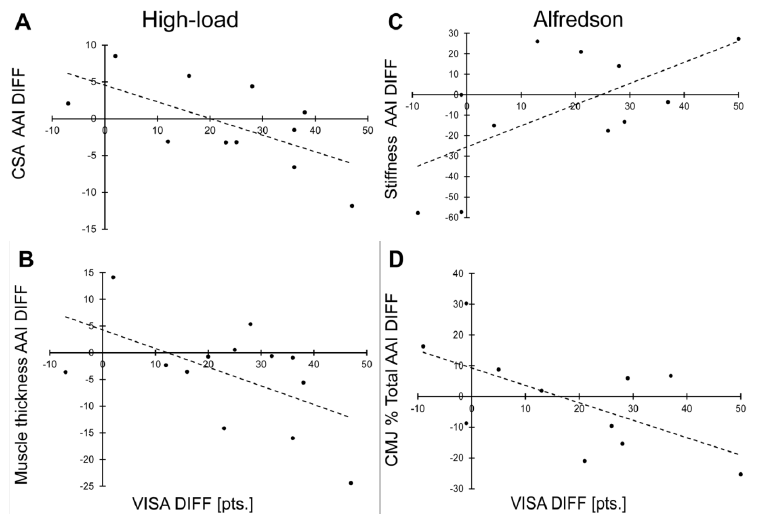
Figure 3. Correlations between the Victorian Institute of Sport Assessment-Achilles questionnaire (VISA-A) change from PRE to POST and the absolute asymmetry index (AAI) change from PRE (at baseline) to POST (after 12 weeks of exercise) in the high-load group for Achilles tendon cross-sectional area (CSA) ( A ) and plantar-flexor muscle thickness ( B ) and in the Alfredson group for Achilles tendon stiffness ( C ) and the percent impulse ratio of both legs for the counter movement jump (CMJ) ( D ), DIFF = difference, pts. = points.